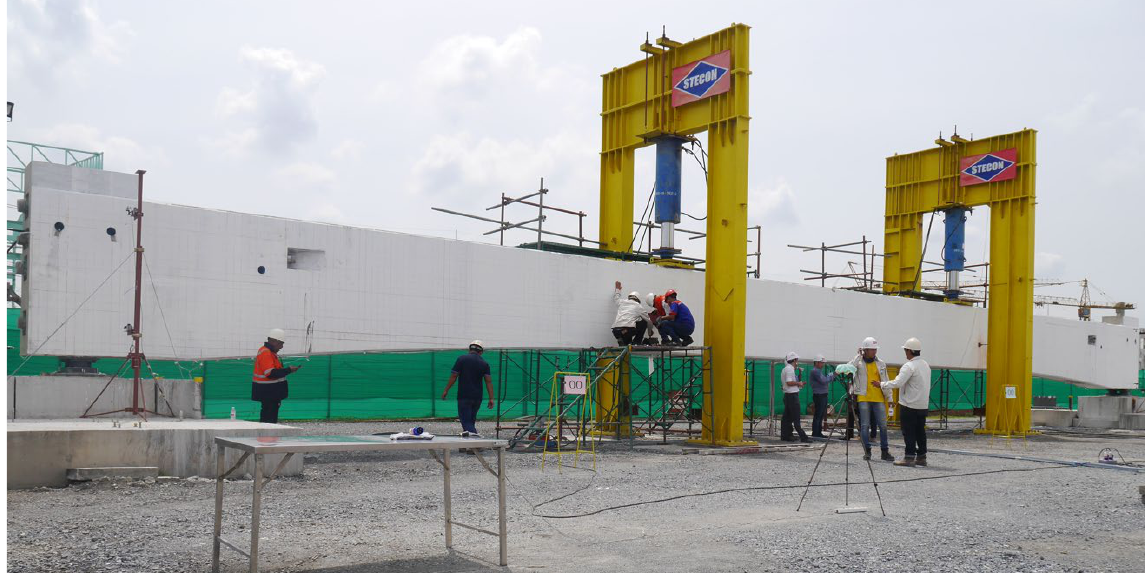
Figure 13. The two-point load applied to specimen SP-02.